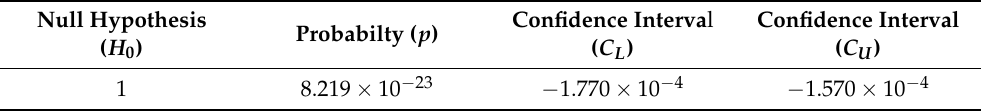
Table 8. Two-sample t-test on PCA features extracted from real-parts of MammoWave’s S 21